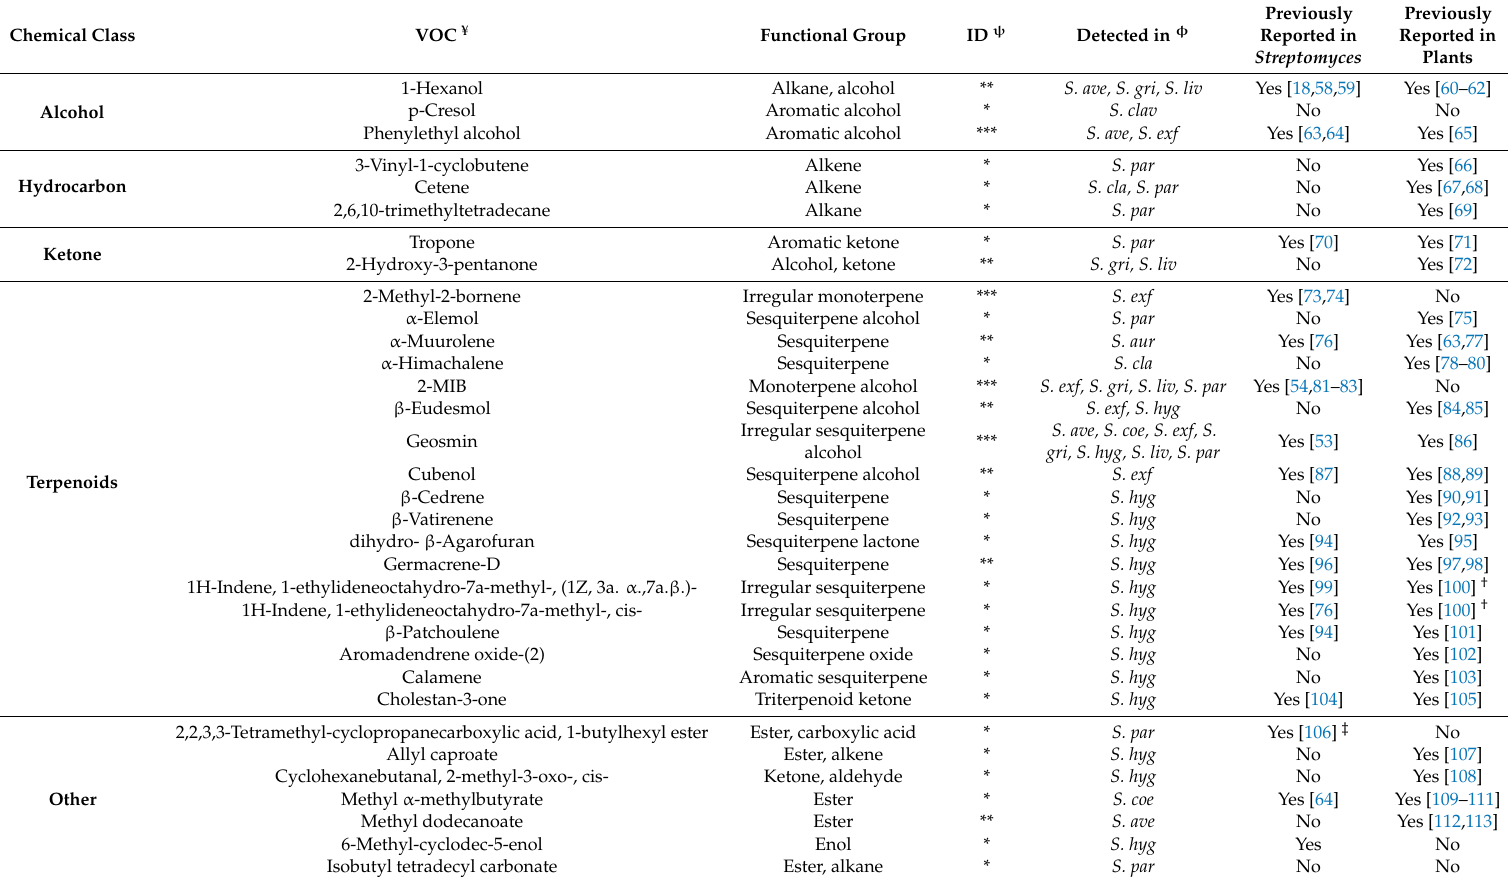
Table 1. Streptomyces -specific VOCs identified in the current